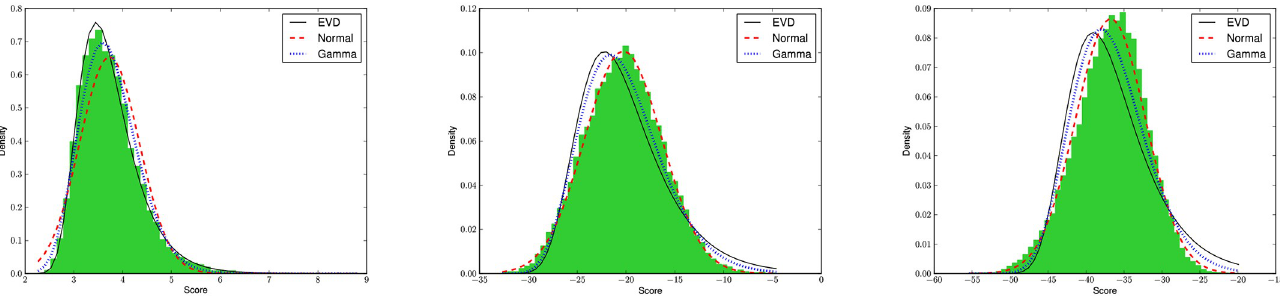
Fig 5. Relative frequency histograms of alignment scores for local (left), semiglobal (middle) and global (right) alignments of random RNAs produced by RNAmountAlign . For the 5S rRNA AY544430.1:375-465 from the Rfam 12.0 database having nucleotide relative frequencies p A = 0.25, p C = 0.27, p G = 0.26, p U = 0.21, we generated 10,000 random sequences having the same nucleotide relative frequencies, each of length 400 nt. For each method (local, semiglobal, global), RNAmountAlign was run using default parameters to determine the optimal pairwise alignment score, when aligning the 5S rRNA with each random RNA, thus producing relative frequency histograms which were subsequently fit by the normal distribution (ND), extreme value distribution (EVD) and gamma distribution (GD). As expected by Karlin-Altschul theory [12], local alignment scores are best fit by EVD, while semiglobal alignment scores are best fit by ND. Our conclusions of the best fitting distributions were additionally supported by d computations of variation distance, symmetrized Kullback-Leibler distance, and χ 2 goodness-of-fit tests (data not